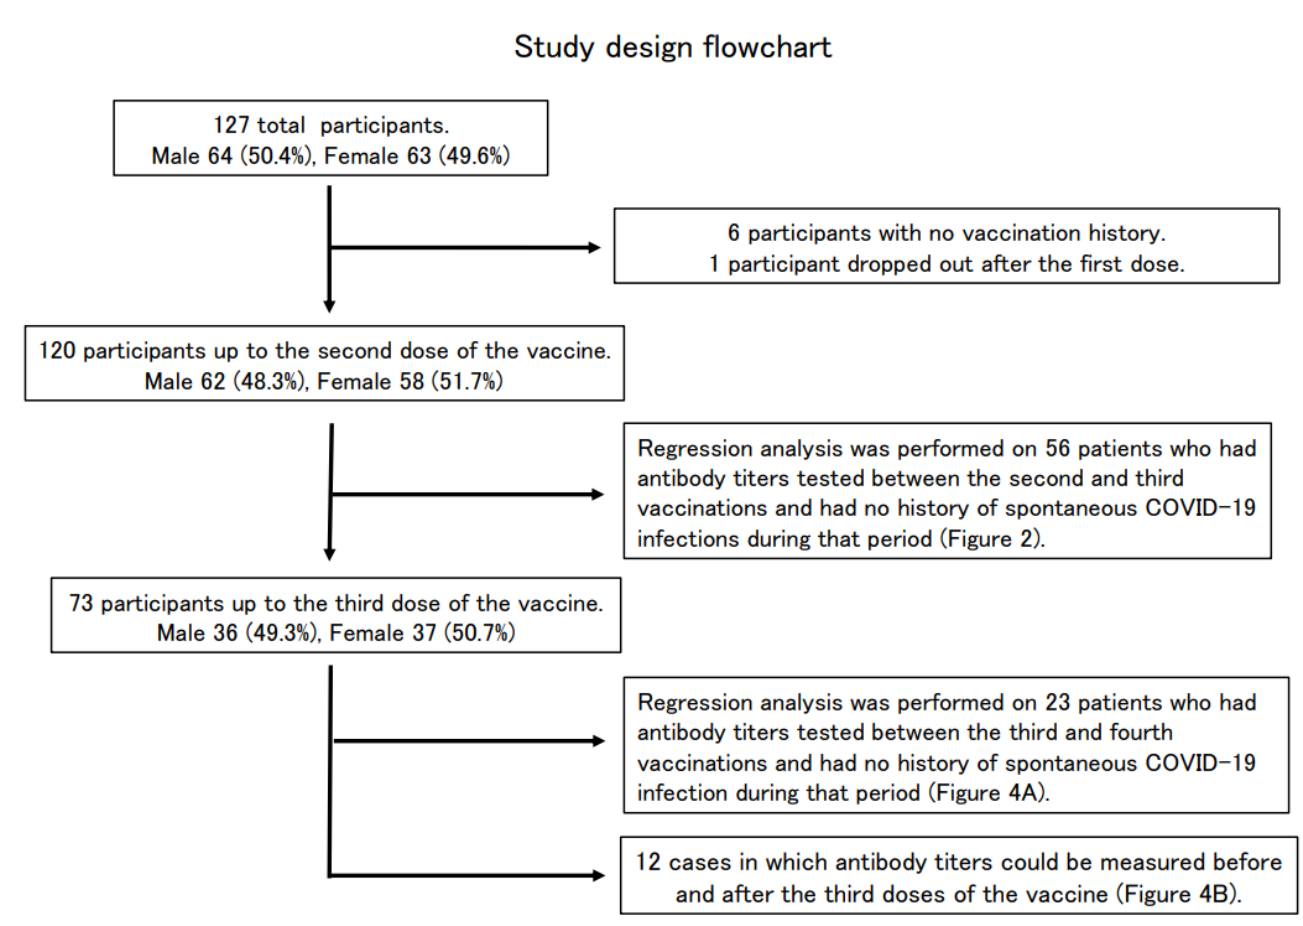
Figure 1. Study design flowchart.